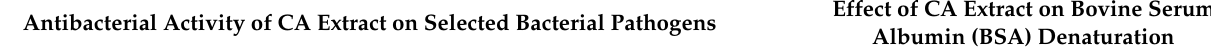
Table 4. Antibacterial and anti-inflammatory effects of CA extract.